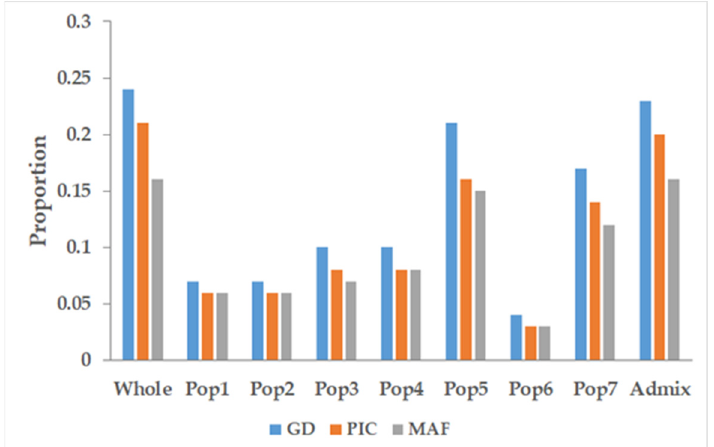
Figure 6. Population-wide marker characteristics. The marker characteristics in terms of the gene diversity (GD), polymorphic information content (PIC), and minor allele frequency (MAF) across the seven subpopulations and the whole population.